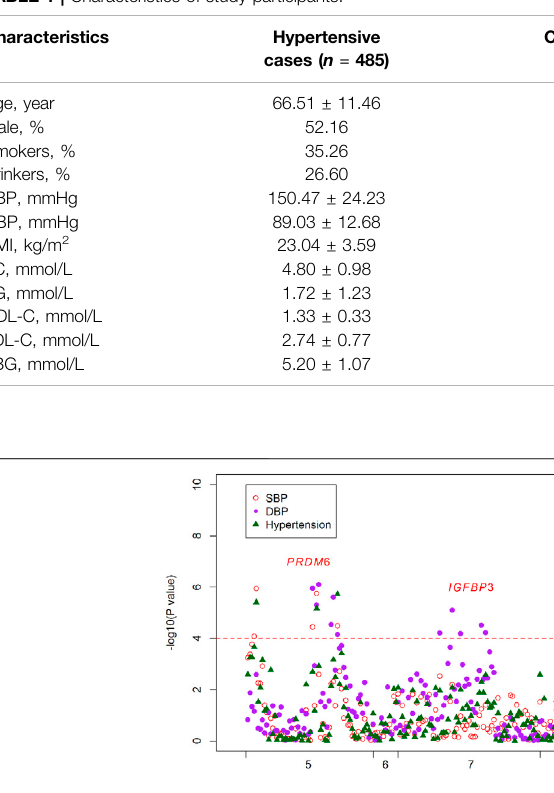
TABLE 1 | Characteristics of study participants.